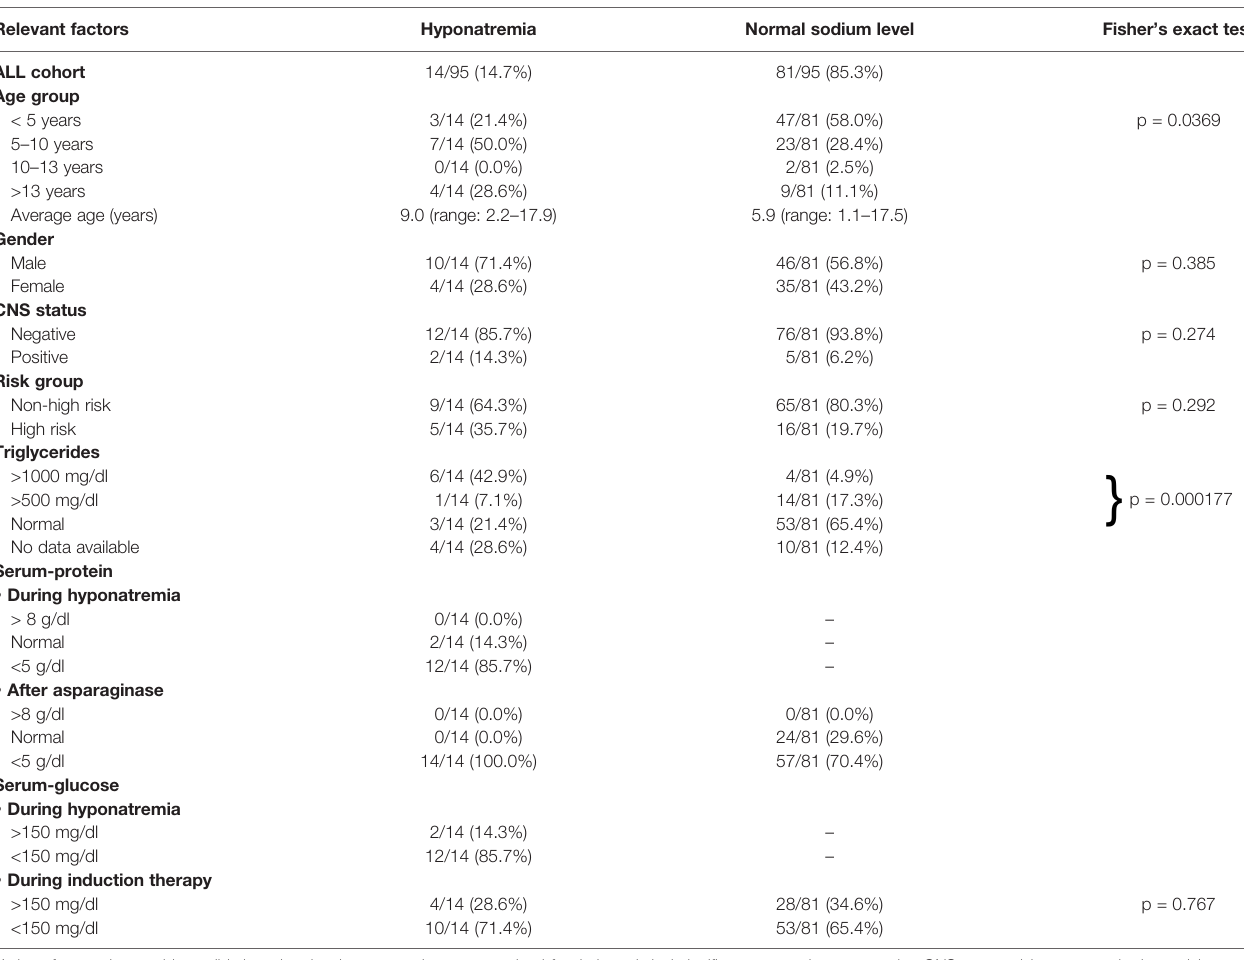
TABLE 2 | Prevalence of hyponatremia in the examined ALL cohort